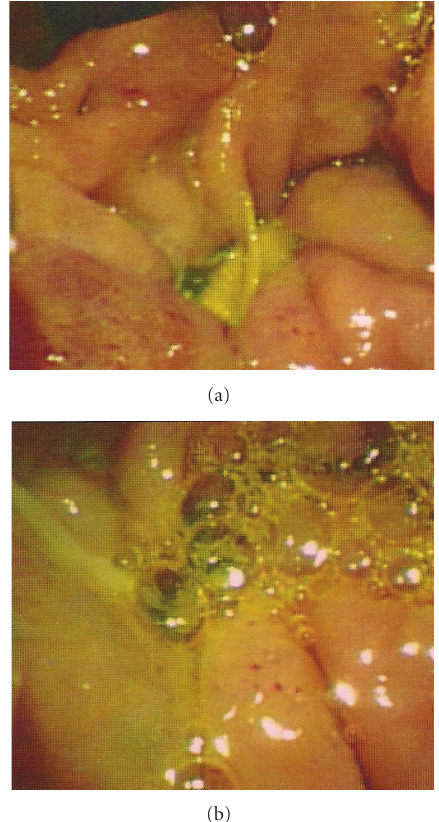
Figure 4: Images from the ERCP showing a duodenal ulcer which was draining pus and